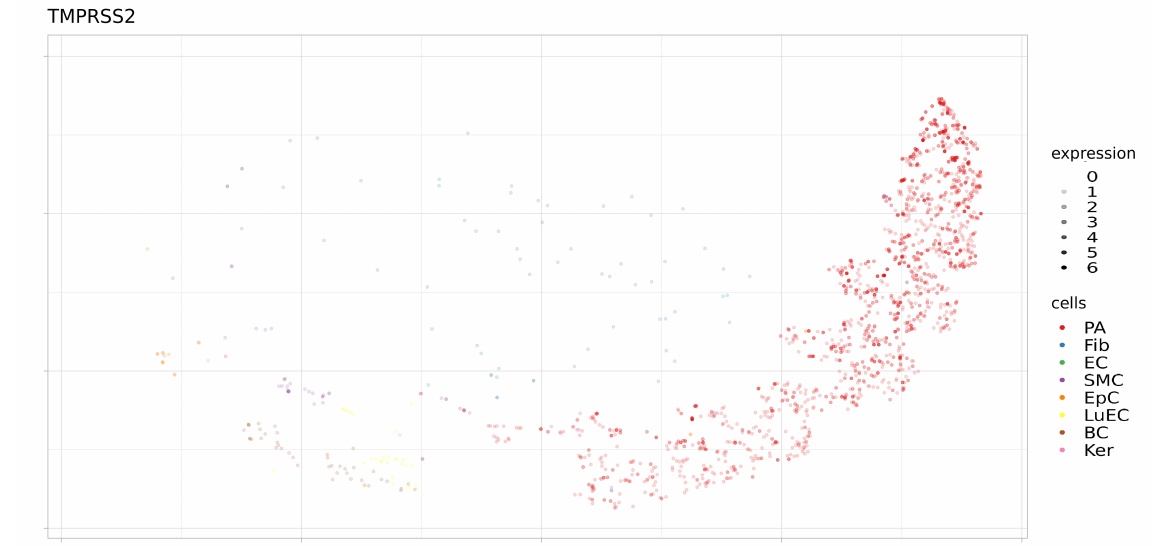
Figure 9. Expression levels TMPRSS2 in separate cells of proximal stromal lung (SRS2769051). PA, pulmonary alveolar type II cells; Fib, fibroblasts; EC, endothelial cells; SMC, smooth muscle cells; LuEC, luminal epithelial cells; BC, basal cells; Ker, keratinocytes. Color intensity indicates the level of expression in a single cell.